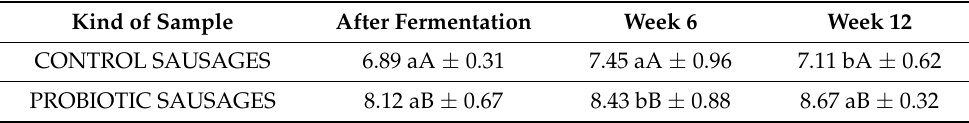
Table 1. The count of LAB of dry fermented pork sausages after fermentation after 6 and 12 weeks of storage (log CFU g − 1